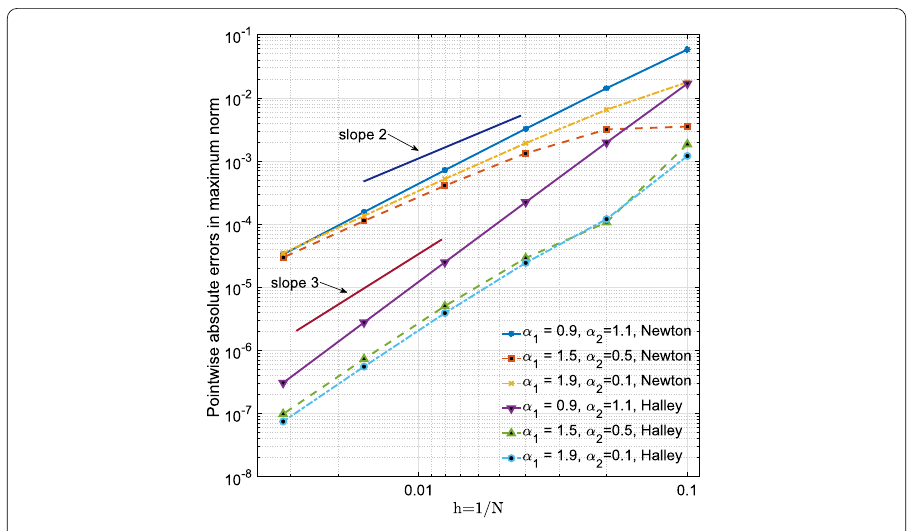
Figure 1 Pointwise absolute errors in maximum norm of Example 4.1 versus the time step h when ( α